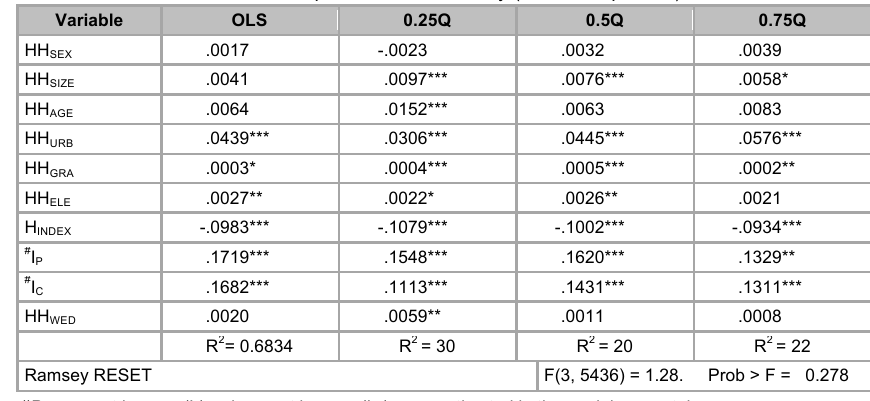
Owner occupier demand elasticity (OLS and